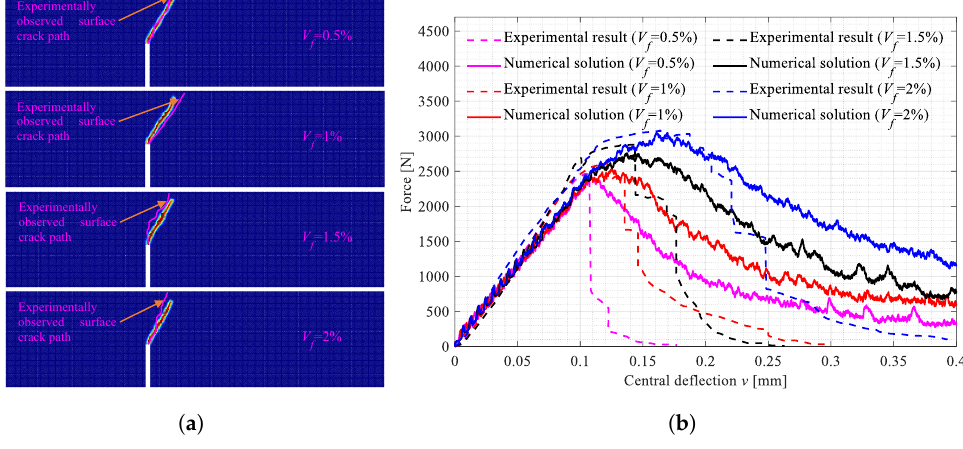
Figure 13. The crack patterns in the beam specimens with C l = 20 mm and the central deflection-force diagrams. ( a ) Surface crack patterns; ( b ) Central deflection-force diagrams.